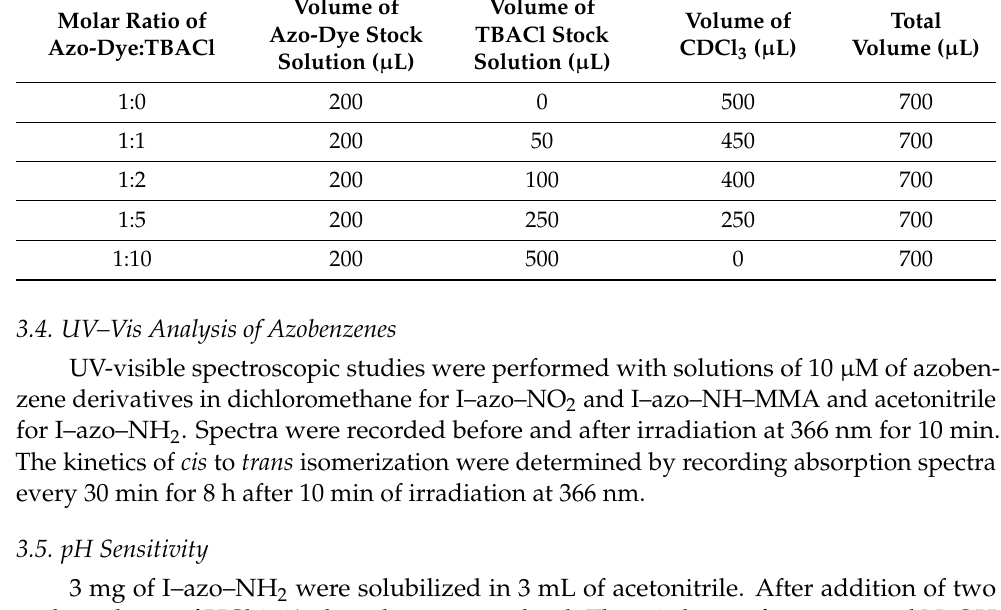
Supplementary Materials: Figure S1: X-ray structures of HOQKAC ( A ), HOTZOH ( B ), PEQVOZ ( C ) and USAJIK ( D ) showing the I ··· CH 2 =C halogen bonds found in the Cambridge Structural white, H; orange, S; purple, I. Figure S2: Stack plot of 19 F-NMR spectra of I–azo–NH 2 (CDCl 3 ), at Figure S3. 1 H and 13 C-NMR spectra for compound OH–azo–NH 2 . Figure S4. 1 H and 13